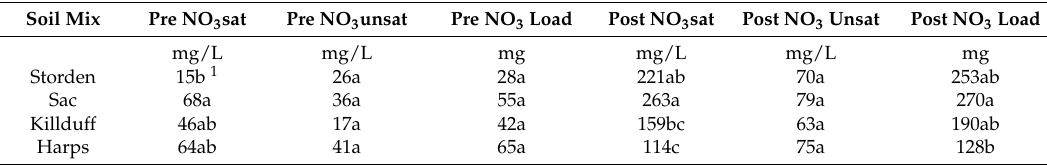
Table 4. Nitrate in saturated and unsaturated effluent of soil mixes (across compost treatments), before planting and after harvest. Also calculated total nitrate load in preplant and post-harvest effluent, based on outflow volumes for saturated and unsaturated effluent.